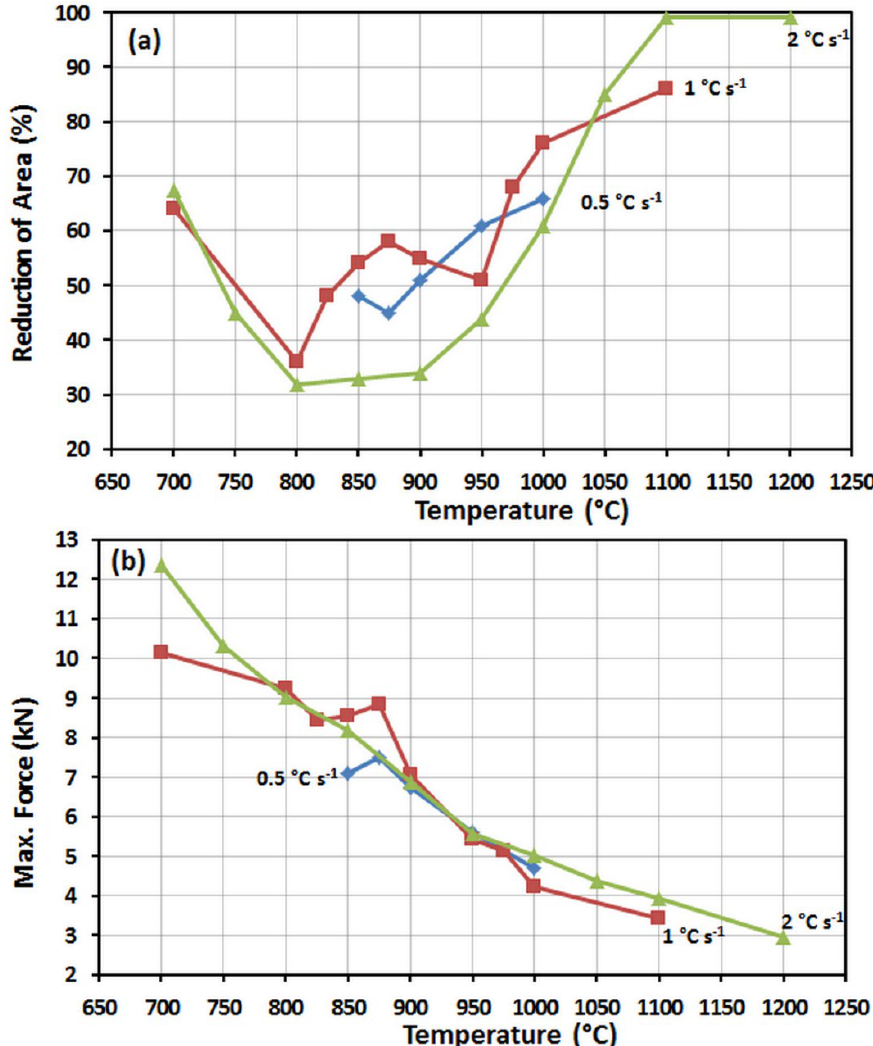
Figure 1. ( a ) Variation of reduction of area (hot ductility) with temperature. ( b ) Variation of maximum force with temperature (έ = 0.1 s −1